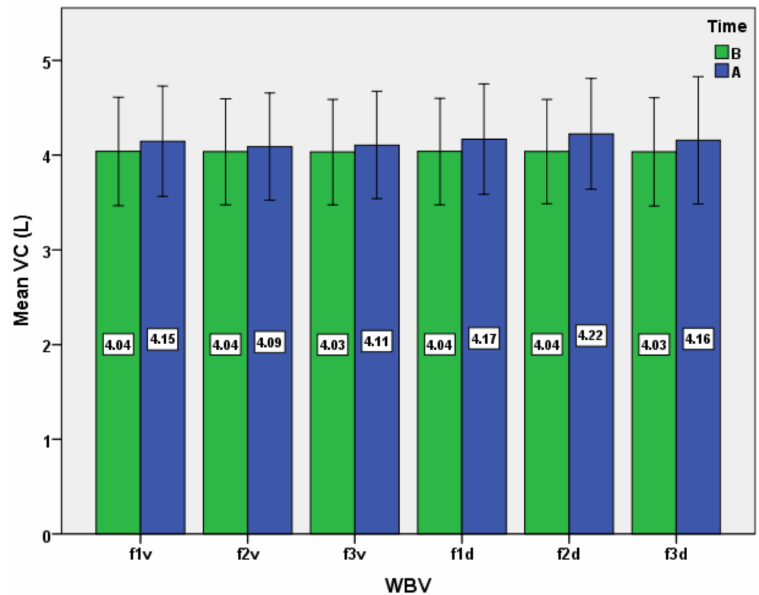
Figure 3. Impact of the WBV exposure on vital capacity (VC) for the six protocols (means and standard deviations). B, before; A,